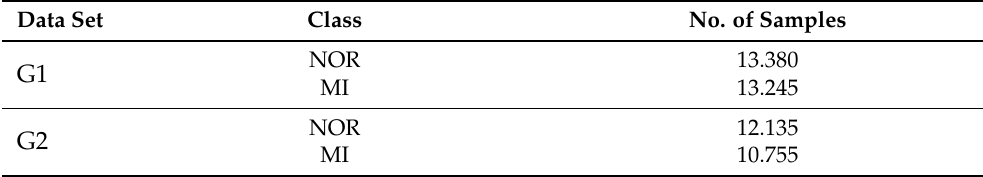
Figure 2. An illustration of two class samples after the preprocessing stage: ( a ) normal sinus rhythm (NOR) and ( b ) myocardial infarction (MI). Table 2. Parameter selections.